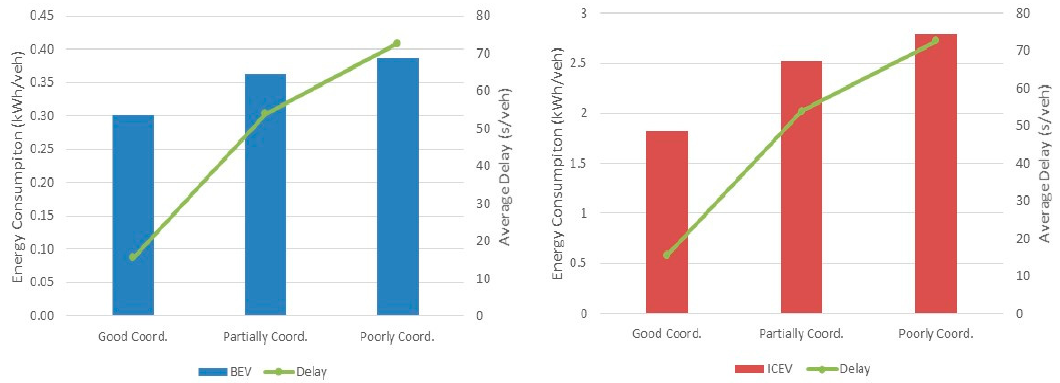
Figure 7. BEV and ICEV energy/fuel consumption for different signal coordination plans.